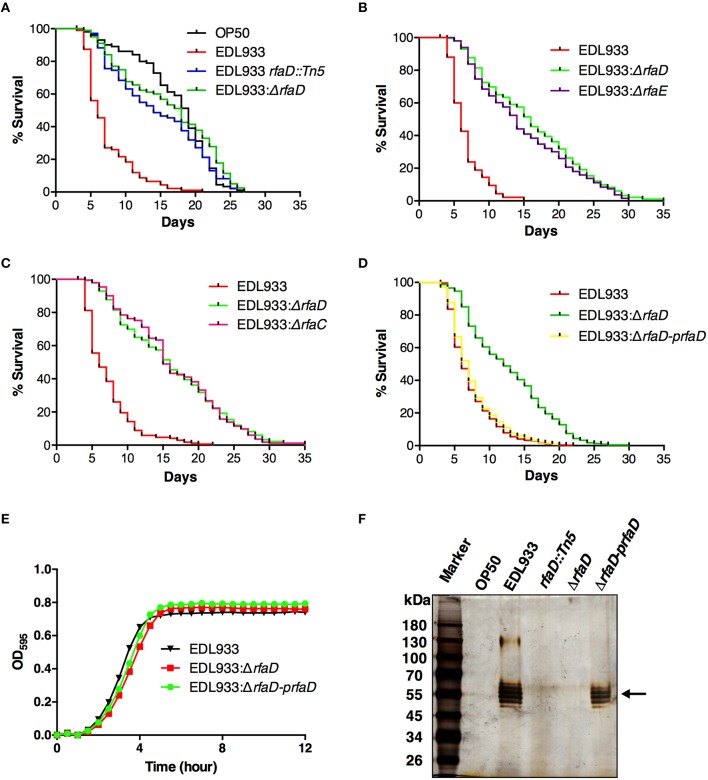
Disruptions of rfaD and the genes involved in EHEC core LPS biosynthesis confer attenuated toxicity. (A–D) Survival curves of N2 animals fed with E. coli strain OP50 (OP50), EHEC strain EDL933 (EDL933), and EDL933 with Tn5 transposon insertion in rfaD (EDL933 rfaD::Tn5), rfaD deletion (EDL933:ΔrfaD), rfaE deletion (EDL933:ΔrfaE) and rfaC deletion (EDL933:ΔrfaC), and EDL933:ΔrfaD with prfaD complementation (EDL933:ΔrfaD-prfaD) were examined. All survival experiments were conducted independently at least three times with approximately 100 animals each time. (A) Animals feeding on the EDL933 rfaD::Tn5 mutant plates (P < 0.001) and the EDL933:ΔrfaD plates (P < 0.001) lived significantly longer than animals feeding on the wild-type EDL933 plates. (B) N2 animals fed with EDL933:ΔrfaE (P < 0.001) lived significantly longer than animals fed with the wild-type EDL933, but were similar to those fed with EDL933:ΔrfaD (P = 0.100). (C) Animals feeding on EDL933:ΔrfaC plates (P < 0.001) lived significantly longer than animals feeding on the wild-type EDL933 plates, but were similar to those on EDL933:ΔrfaD (P = 0.938). (D) N2 animals fed with EDL933:ΔrfaD (P < 0.001) lived significantly longer than animals fed with EDL933 wild type. The survival curve of N2 animals fed with EDL933:ΔrfaD-prfaD was similar to that of wild-type EDL933 (P = 0.128). (E) Growth curves of wild-type EDL933 and rfaD mutants in LB broth at 37°C. Both the growth kinetic curves of EDL933:ΔrfaD and EDL933:ΔrfaD-prfaD, were similar to wild-type EDL933. (F) The LPS samples of OP50, EDL933, EDL933 rfaD::Tn5, EDL933:ΔrfaD, and EDL933:ΔrfaD-prfaD was examined by silver staining. O-antigens are indicated by the black arrow.